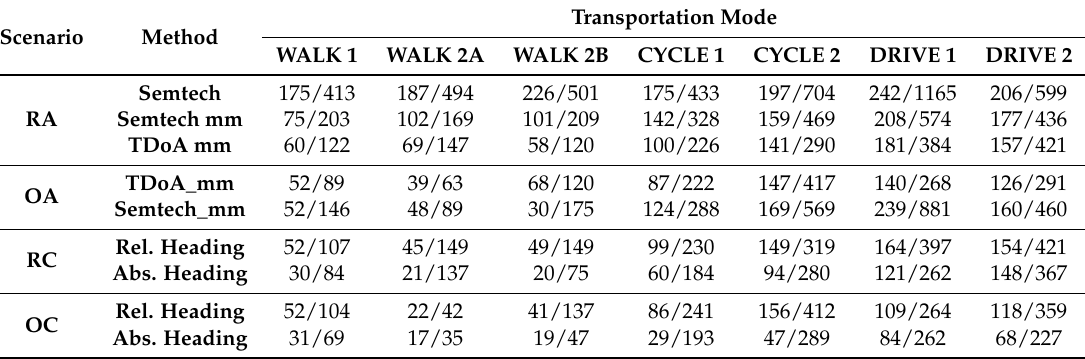
Table 3. Summary of the obtained p 50 / p 90 accuracies (in meters) for the various scenarios, methods, and